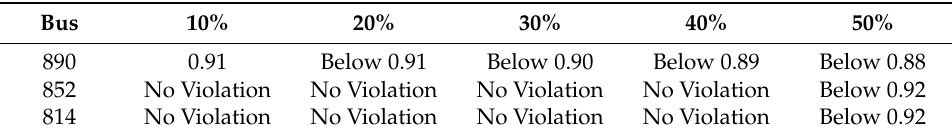
Table 6. Case 2 Maximum Charging Load kW during Peak Table 6 . Case 2 Maximum Charging Load kW during Peak Hours. Table 6 . Case 2 Maximum Charging Load kW during Peak Hours.